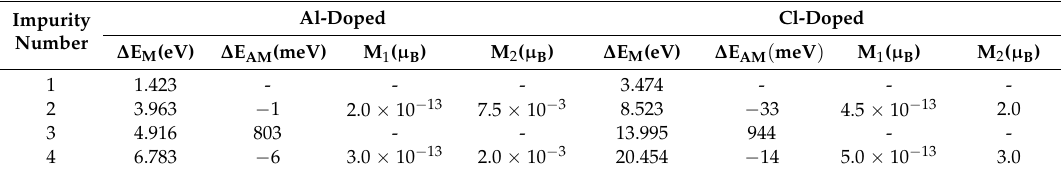
Table 1. Energy differences and magnetic moments of different doped phosphorenes.